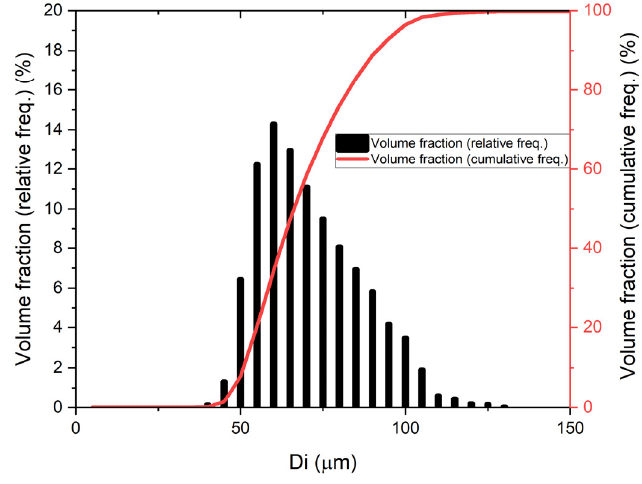
Figure 1. M300 maraging steel powder ( a ) morphology of the particles (SEM); ( b ) metallographic cross-section.